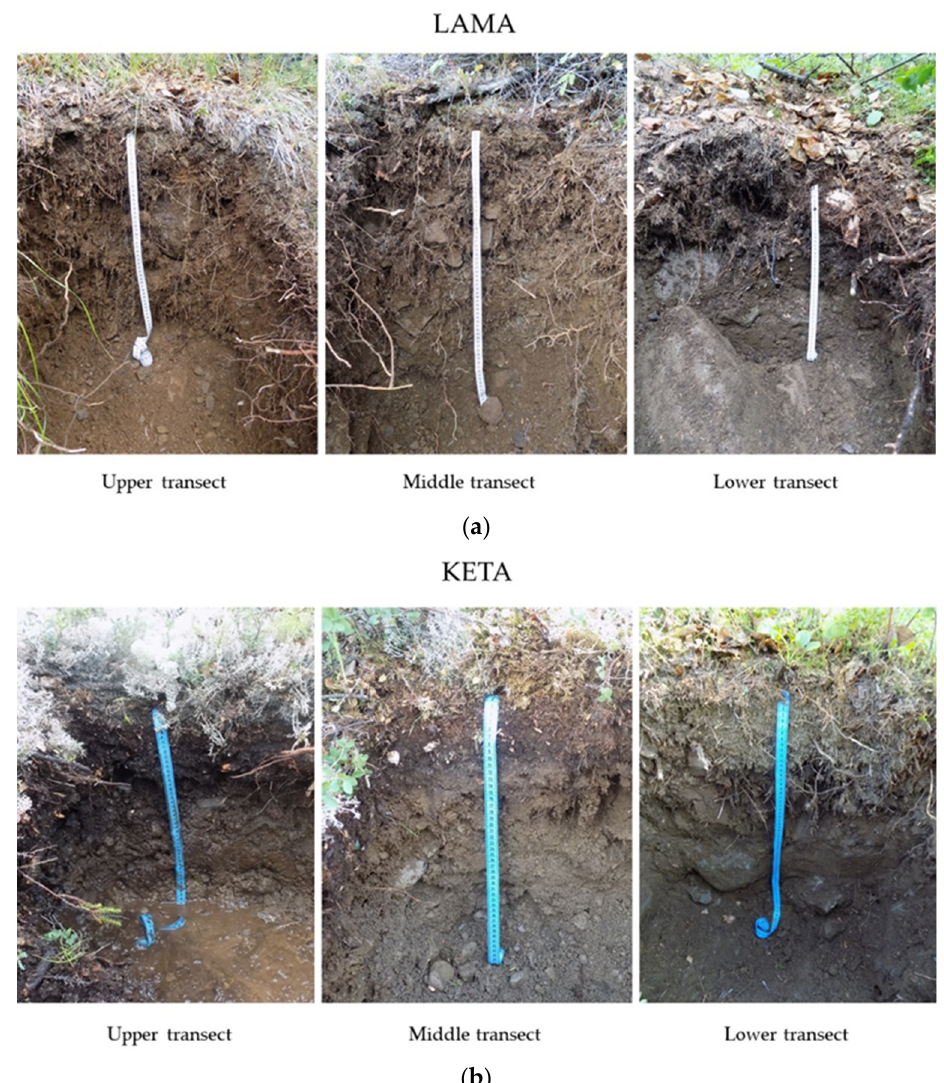
Figure 2. Soils of the upper, middle, and lower transects at the locality Lama ( a ) and Keta ( b ). Soil samples were air-dried and sieved (<2 mm) prior to the analyses. The basic phys-